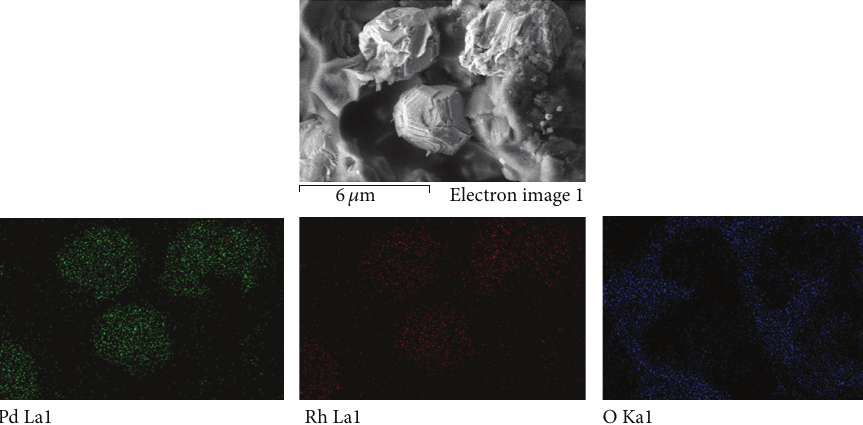
Figure 5: SEM elemental mapping for the bimetallic